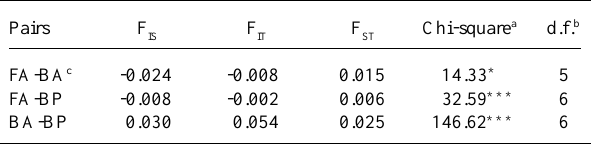
Table V - F-statistics analysis between varieties of “ Alberes ” and the “ Bruna dels Pirineus ” breed, compared in pairs.